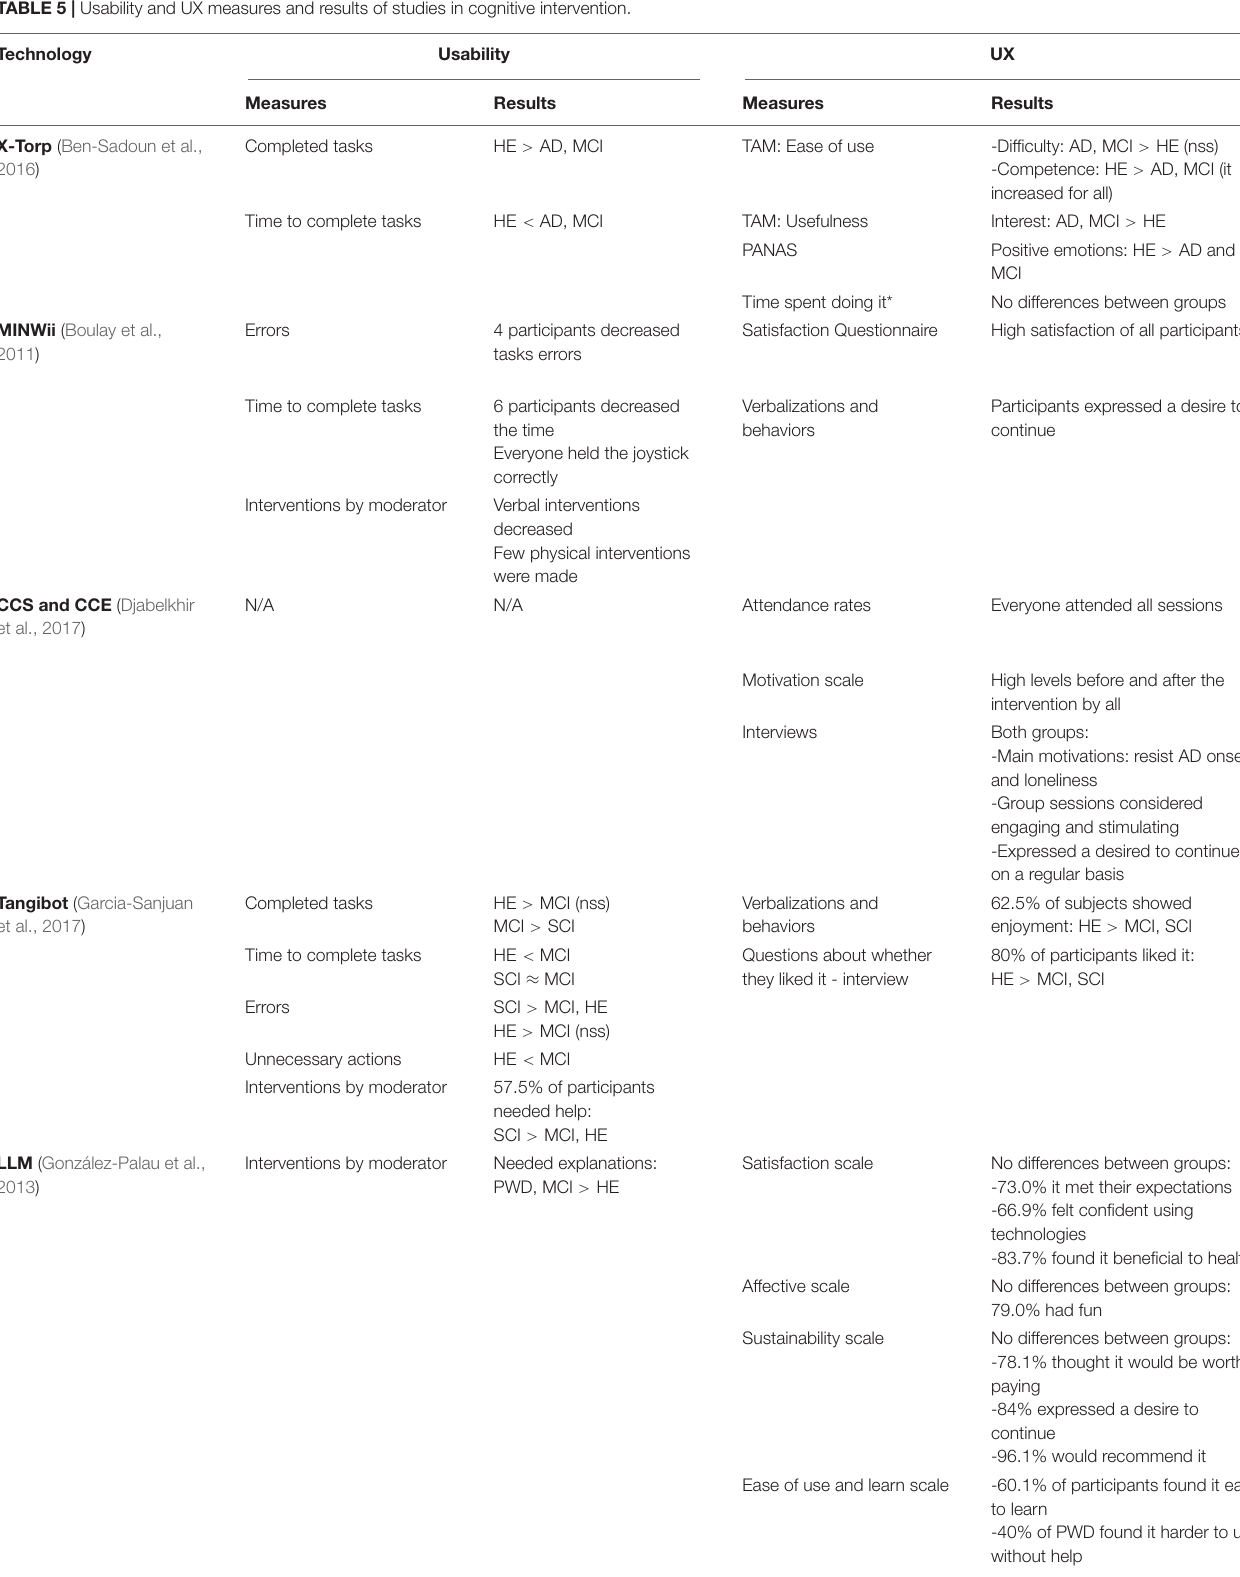
TABLE 5 | Usability and UX measures and results of studies in cognitive intervention.